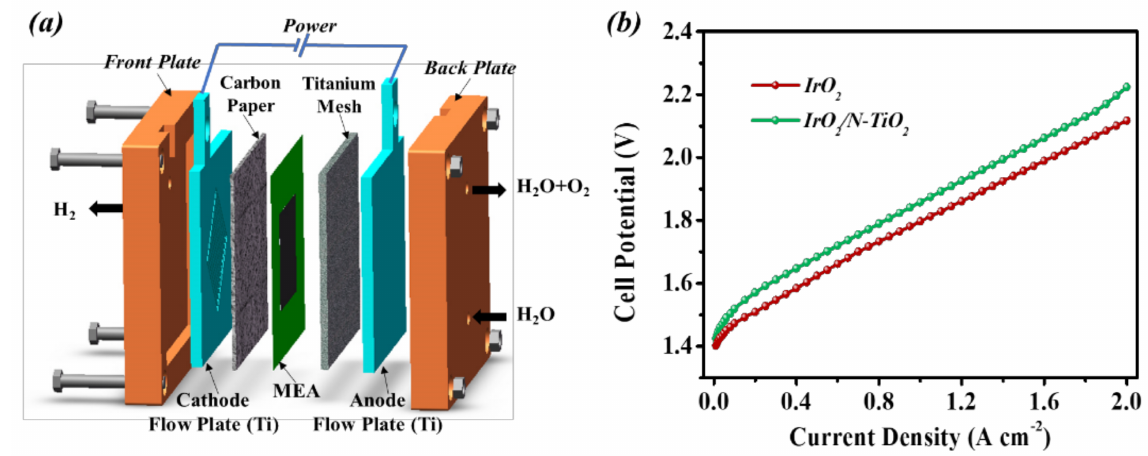
Figure 4. ( a ) Schematics of the home–made PEM single cell; reproduced with permission from Lv, H.; Wang, S.; Li, J.; Shao, C.; Zhou, W.; Shen, X.; Xue, M.; Zhang, C, Appl. Surf. Sci.; published by Elsevier, 2020 [17]; ( b ) polarization curves of IrO 2 and IrO 2 /N–TiO 2 with the potential from 0.01 to 2 A cm − 2 at 80 ◦